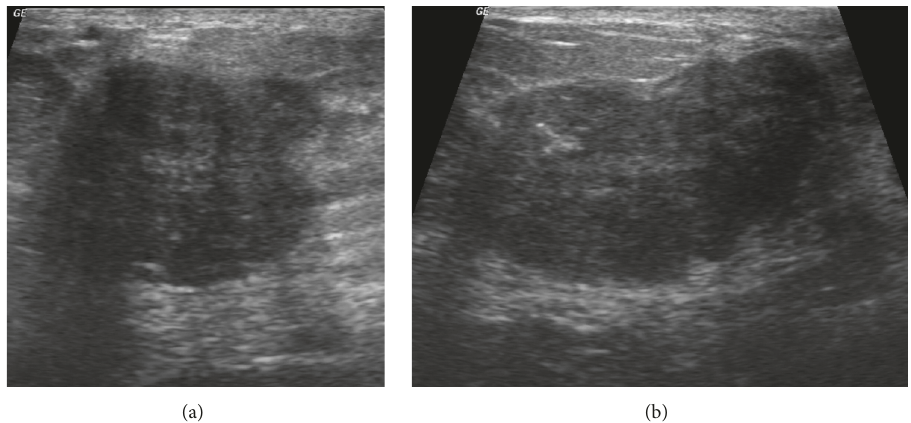
Figure 1: Transverse (a) and longitudinal (b) ultrasonography images showing a solid hypoechoic and heterogeneous mass with microlobulated contours, measuring 3.6 cm × 2.9 cm × 2.3 cm, with long transversal axis of the external superior quadrant of the right breast (collection of the Department of Imaging, the University Teaching Hospital of Lom´e).